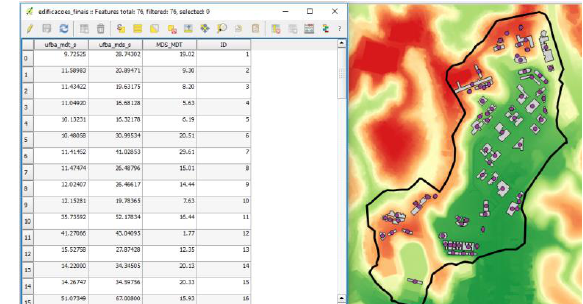
Figure 6: Values obtained from the DSM normalization for each centroid